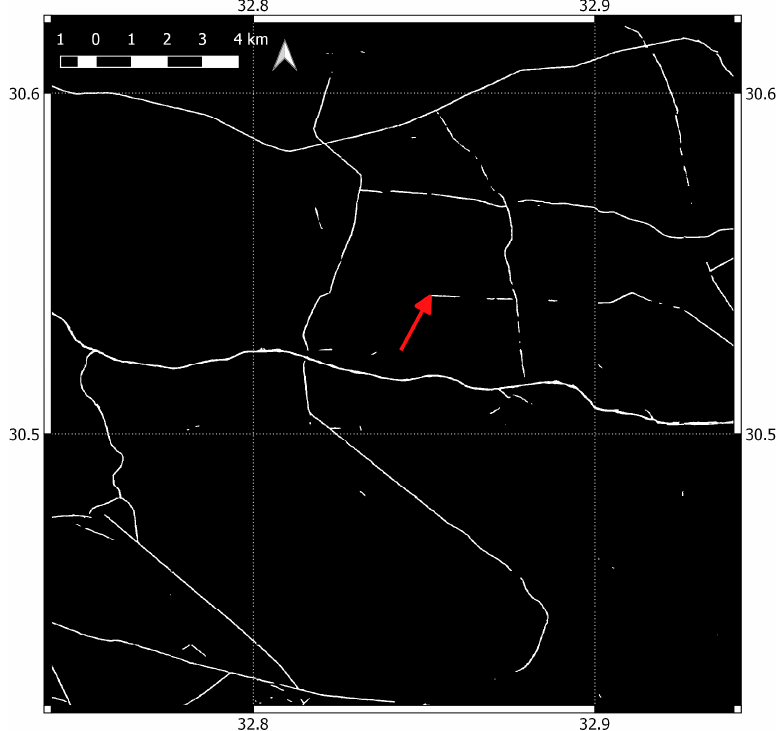
Figure 7. Detected roads for a randomly selected 0.2 × 0.2 degree subset over the North Sinai area. White lines correspond with detected roads. The red arrow points to an example of a buried road segment.